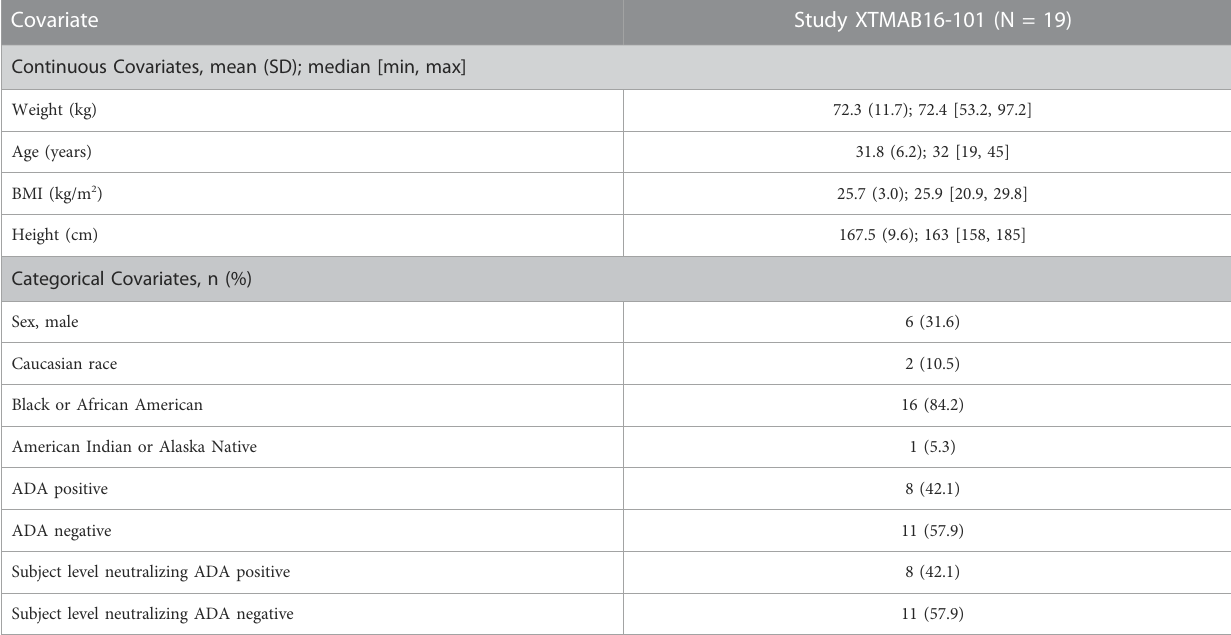
TABLE 1 Summary of continuous and categorical covariates. Covariate